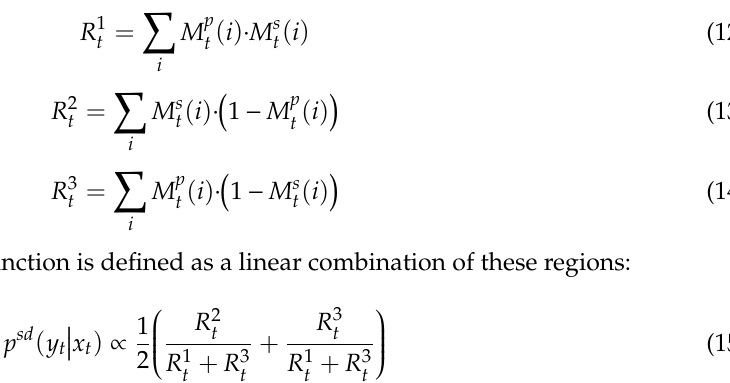
( b ) Figure 6. Path Movement for the three sequences. The blue lines correspond to the path followed by the person during his movement around the sensor. The green areas represent the regions where the person is tracked by the SmartTrack system. ( a ) Sequence 1 and 2, ( b ) Sequence 3.